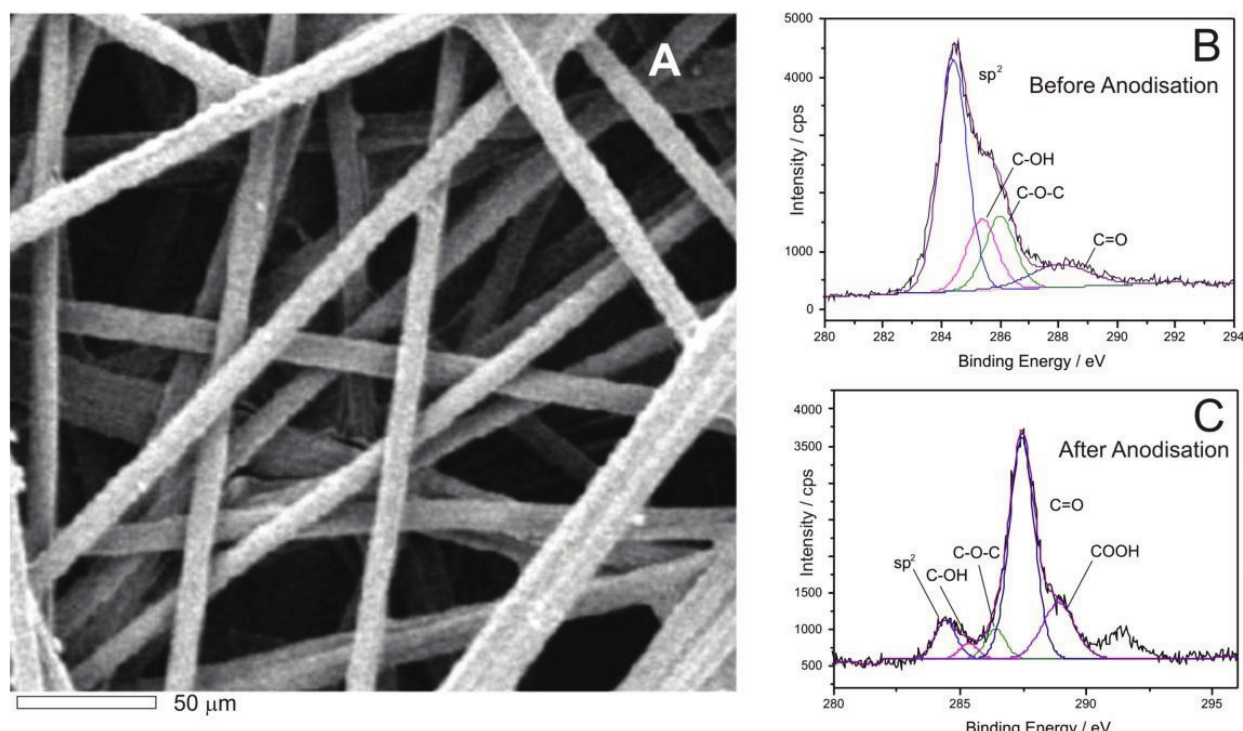
Figure 4. Scanning electron micrograph of the carbon fibre mesh ( A ); and XPS spectra obtained before ( B ); and after ( C ) electrochemical anodisation